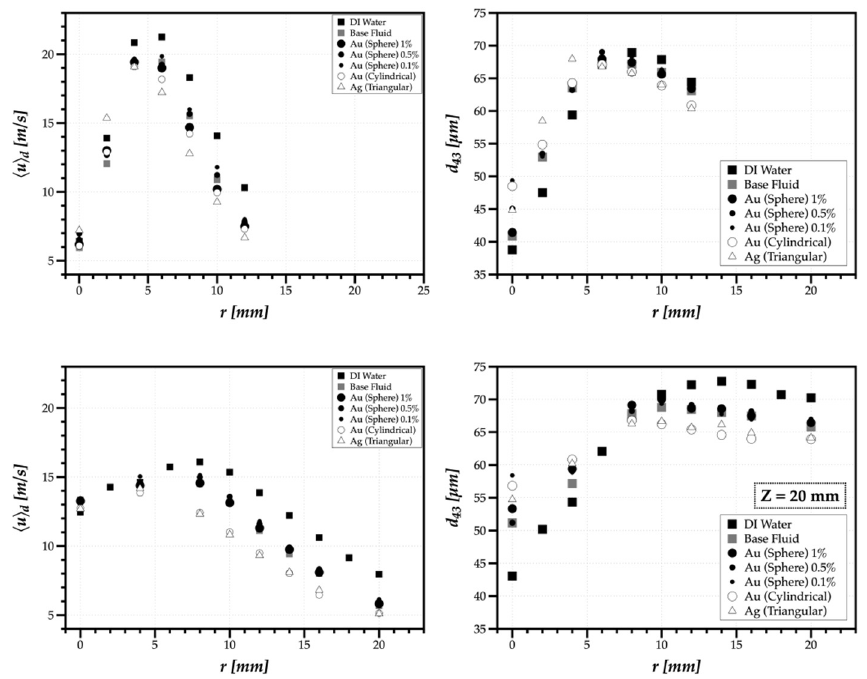
Figure 5. Mean velocity, (cid:104) u (cid:105) d (m / s), and mean diameter, d 43 ( µ m), of droplets for Z = 10 mm ( top ) and Z = 20 mm ( bottom ).